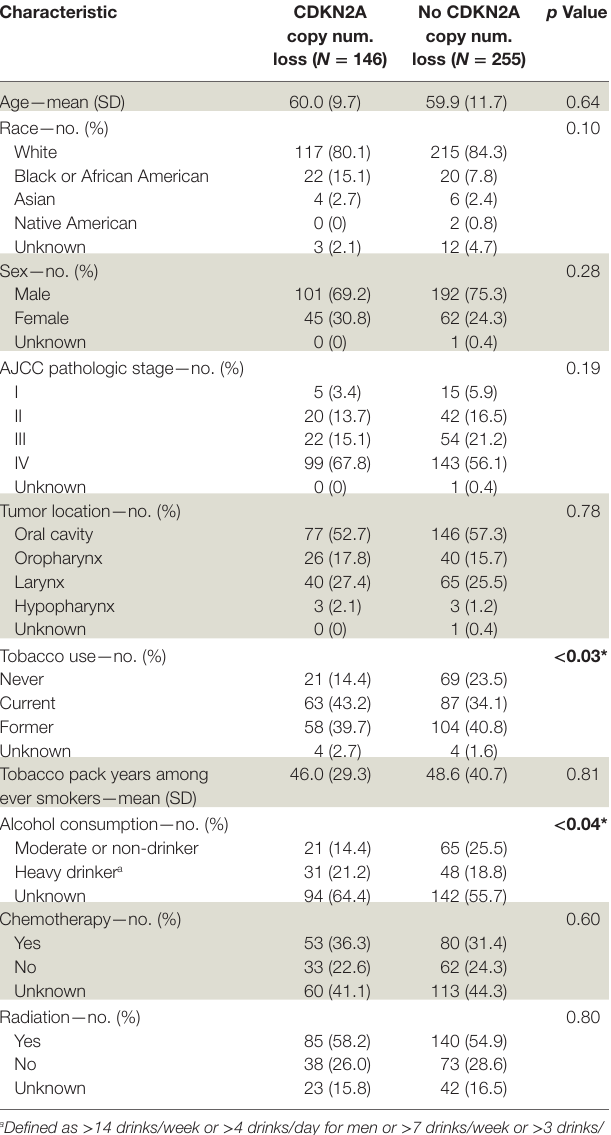
TaBle 1 | Demographic and clinicopathologic characteristics of all HPV-negative head and neck squamous cell carcinomas stratified by CDKN2A copy number. characteristic cDKn2a copy